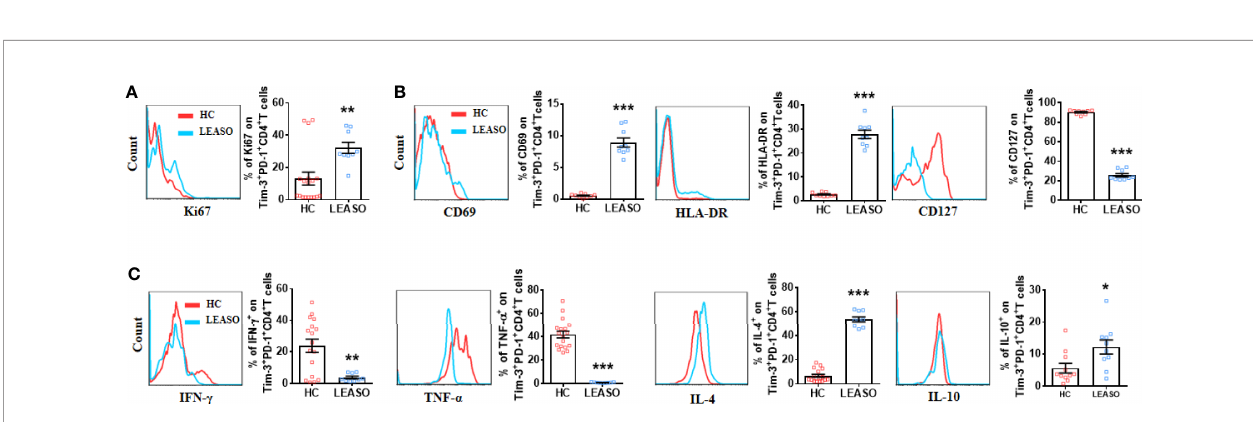
FIGURE 3 | Altered phenotype of Tim-3 + PD-1 + CD4 + T cells from LEASO patients compared to those from HCs in vitro . (A) Expression of Ki67 by Tim-3 + PD- 1 + CD4 + T cells from HC (n = 18) and LEASO (n = 9). (B) Expression of activation markers by Tim-3 + PD-1 + CD4 + T cells from HCs (n = 9) and LEASO (n = 9). (C) Flow cytometric analysis and the quanti fi cation of fl ow cytometric analysis of pro-atherogenic cytokines (IFN- g and TNF- a ) and anti-atherogenic cytokines (IL-4 and IL-10) in Tim-3 + PD-1 + CD4 + T cells from HCs (n = 11-18) and LEASO (n = 9). Data represent mean ± SEM. *P < 0.05, **P < 0.01, ***P < 0.001.